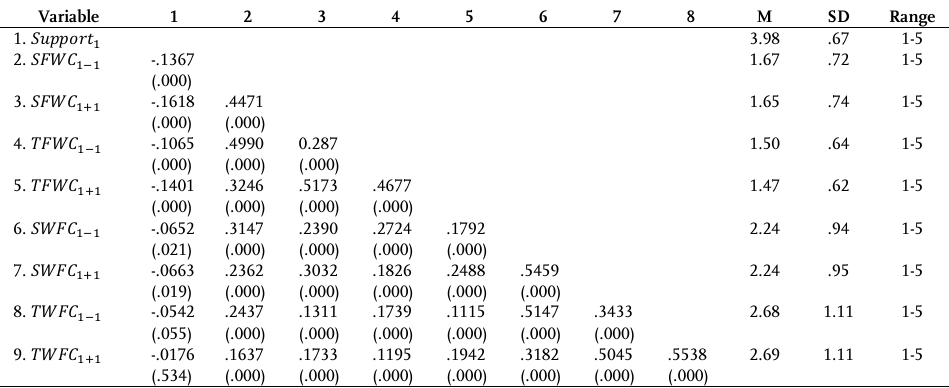
Table 2 : Correlations and descriptive statistics for perceived partner support and all distinguished types of work-family conflicts at